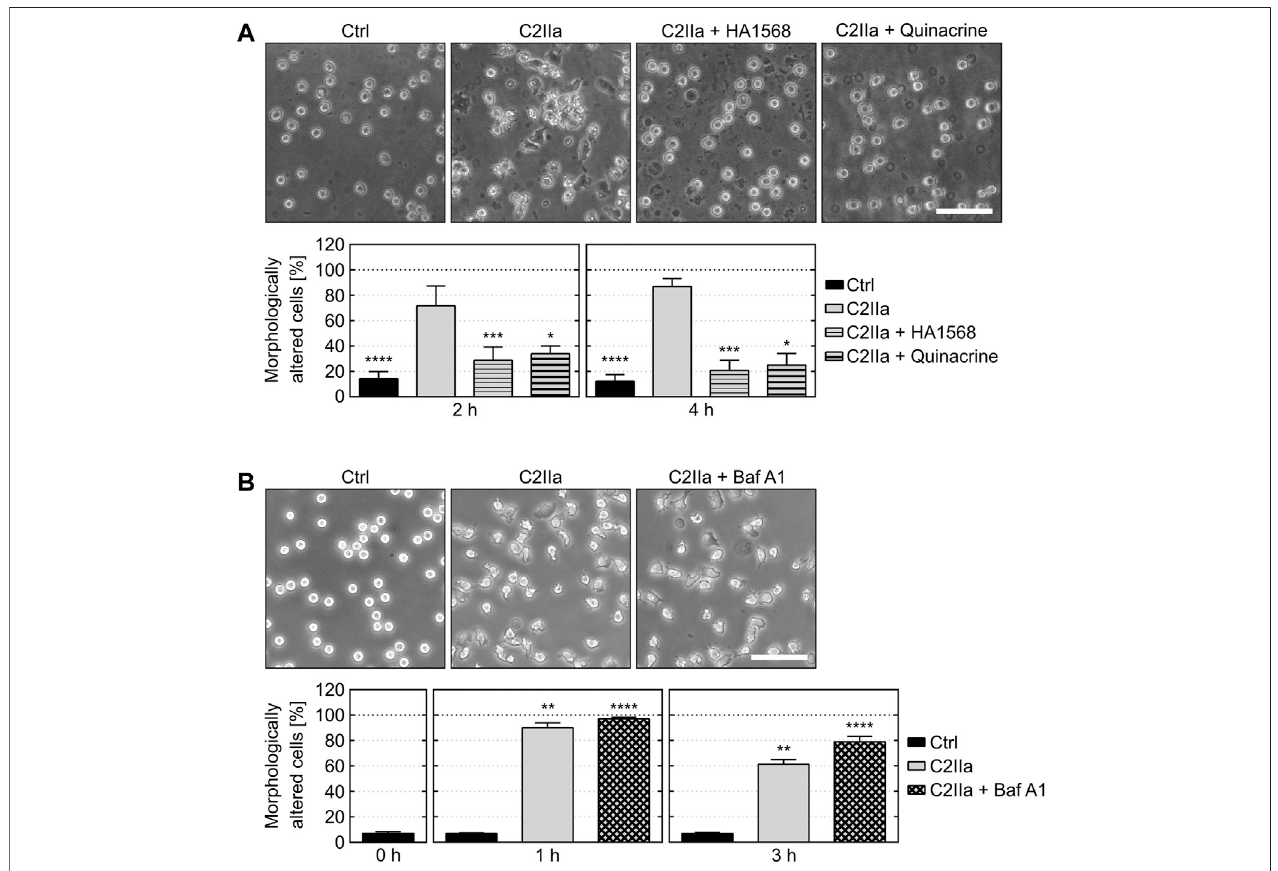
FIGURE 2 | Effect of pore blockers and ba fi lomycin A1 on C2IIa-induced changes in PMN morphology. (A) The pore blockers HA1568 and quinacrine protect PMNsfromC2IIa-inducedmorphologicalchanges.Upperpanel:RepresentativepicturesshowthemorphologyofPMNsafter4 htreatment(37 ° C)withC2IIa(1 μ g/ml)in the presence or absence of the established pore blockers HA1568 (100 µM) and quinacrine (5 µM). Additional PMNs were left untreated as control (Ctrl). Scale bar: 100 µm. Lower panel: The percentage of morphologically changed PMNs was quanti fi ed after 2 and 4 h and is depicted as mean ± SEM (n = 9 – 15, i.e., 3 – 5 independent experiments with 3 technical replicates for each condition, respectively). Signi fi cance was tested against the sample treated with C2IIa only using Kruskal – Wallis test with Dunn ’ s correction for multiple comparison (* p < 0.05, *** p < 0.001, **** p < 0.0001). (B) Inhibition of endosomal acidi fi cation by ba fi lomycin A1 (Baf A1) has no impact on the C2IIa-induced morphological changes ofPMNs. Upper panel: Representative pictures show the morphology ofPMNsafter 1 h treatment (37 ° C) with C2IIa (2 μ g/ml) with or without Baf A1 (100 nM). Further PMNs were left untreated as control (Ctrl). Scale bar: 100 µm. Lower panel: The percentage of morphologically altered PMNs was quanti fi ed after the indicated time points and is depicted as mean ± SEM of three independent experiments, each with 3 technical replicates(n=9).Signi fi cancewastestedagainsttheuntreatedcontrol(Ctrl)usingKruskal – WallistestcombinedwithDunn ’ smultiplecomparisontest(** p < 0.01,**** p <